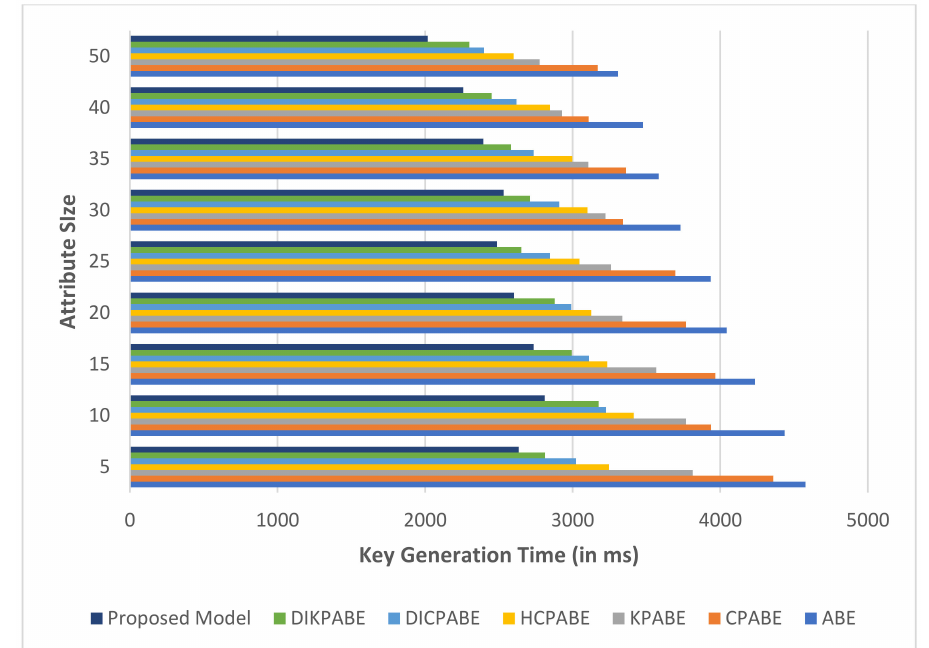
Figure 11. Comparative analysis of chaotic key creation time band and whole amount of cloud consumers’